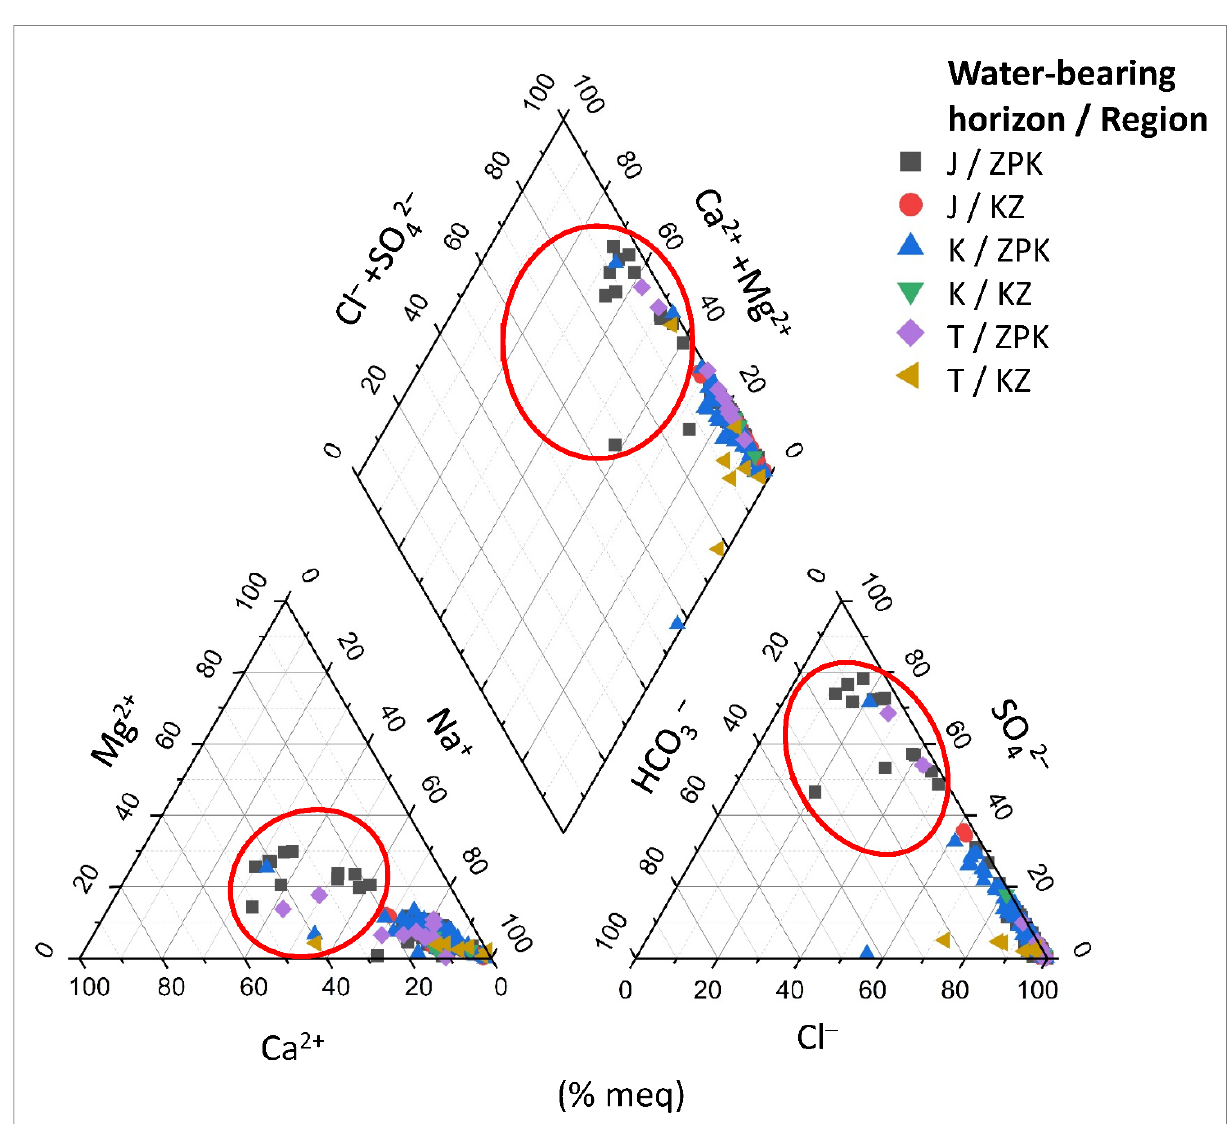
Figure 5. Piper diagram for the analyzed waters with the division into the water-bearing horizons (K, J, T) and the regions (ZPK, KZ).